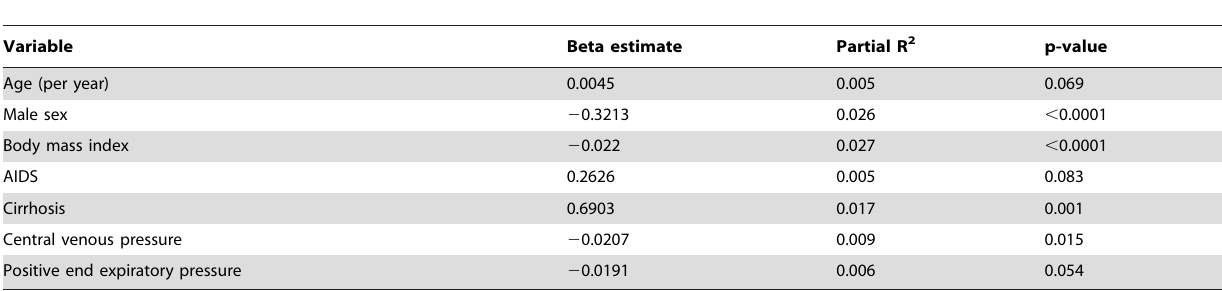
Table 1. Multivariable-adjusted model of factors associated with baseline adiponectin levels.